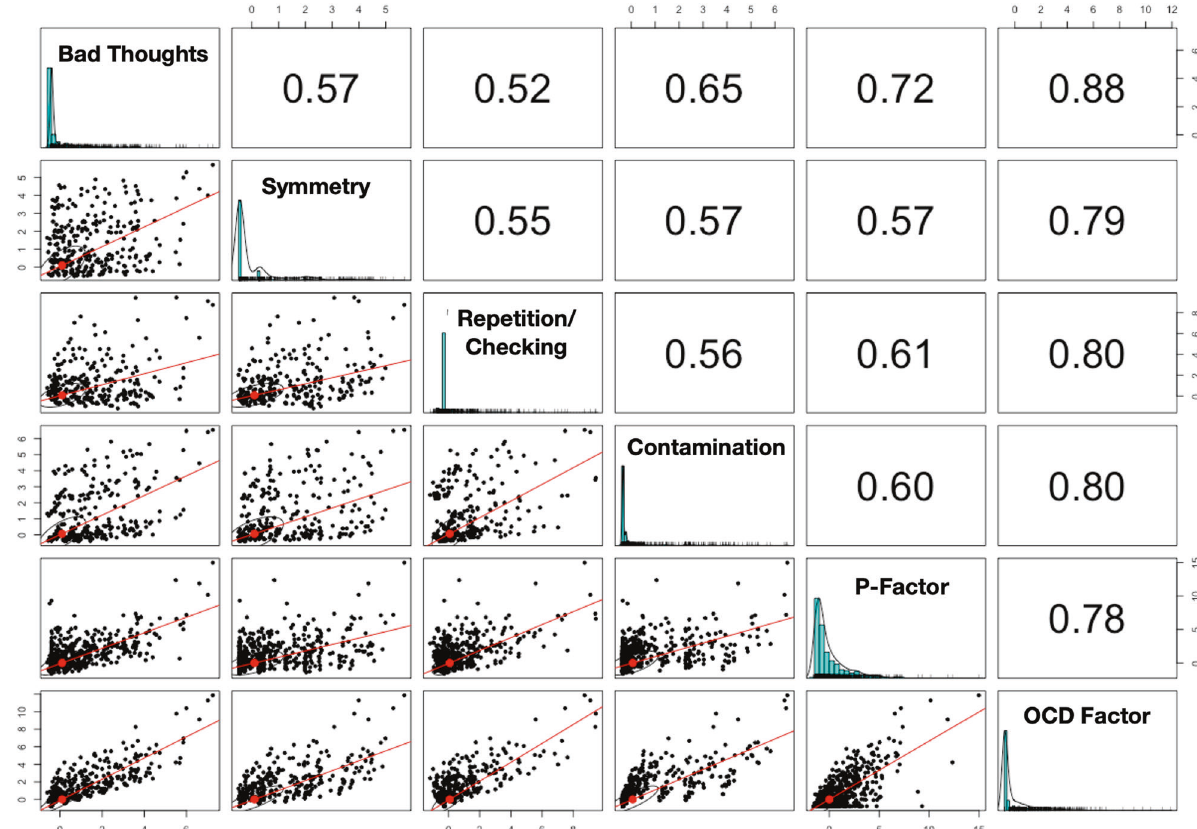
Fig. 1 Correlations among extracted factor scores in the imaging subset. The diagonal contains frequency histograms for each trait. The upper diagonal contains zero-order correlations, and the lower diagonal presents scatterplots of these correlations.